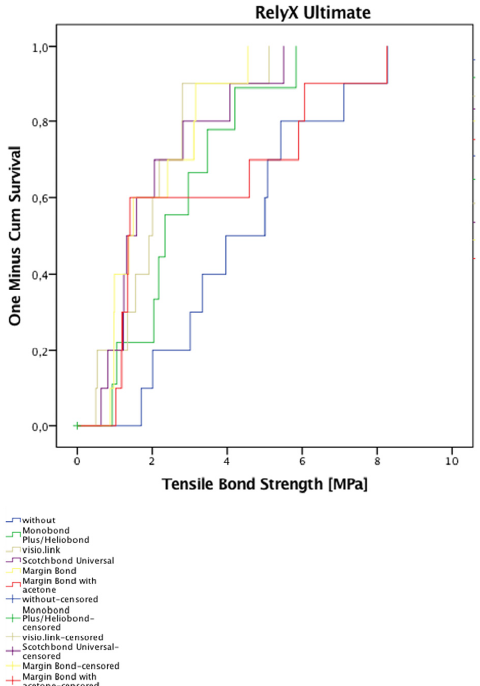
Figure 3. Estimated cumulative failure functions of specimens bonded with RelyX Ultimate.